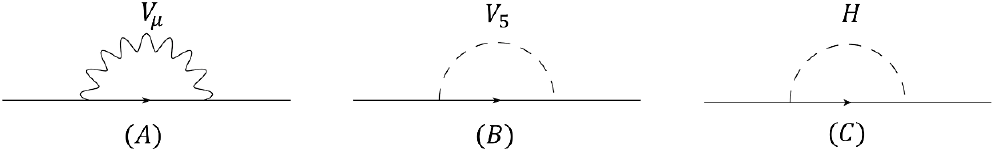
Figure 3 . Generic Feynman diagrams for the one-loop contributions to the self-energy of KK fermions. See caption of (cid:12)gure 1 for further